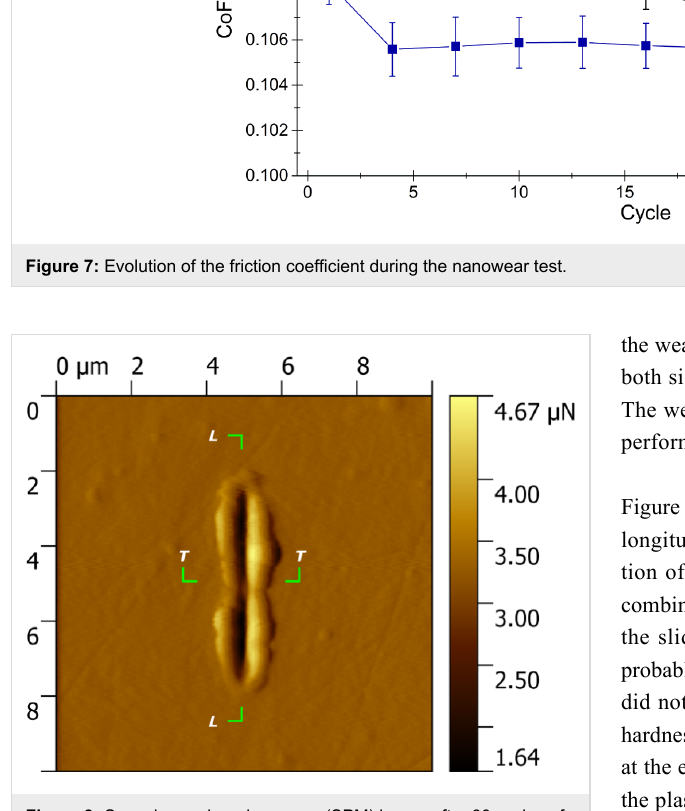
Figure 8: Scanning probe microscopy (SPM) image after 30 cycles of nanoscratch testing in a DCT specimen. The depth profiles below in Figure 9 were taken in the longitudinal (L–L) and transversal (T–T)